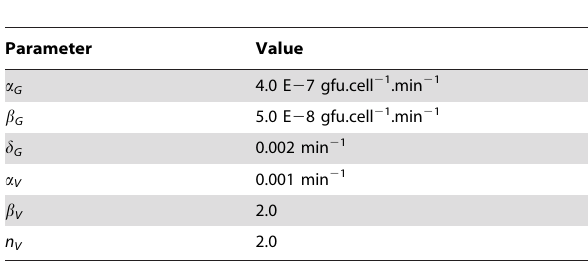
Table 1. Parameter values for the inflammation-influx sub-